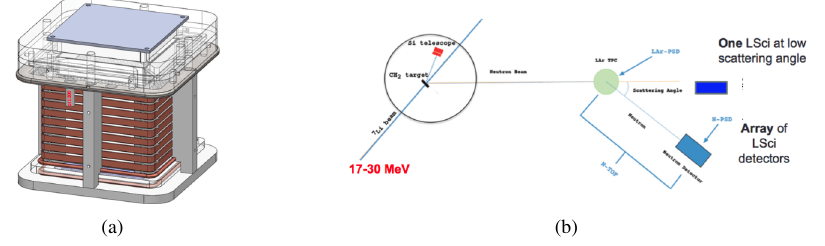
Figure 1. (a) Schematic drawing of the ReD dual-phase LAr TPC. (b) The ReD experimental setup (drawing) at INFN Laboratori Nazionali del Sud